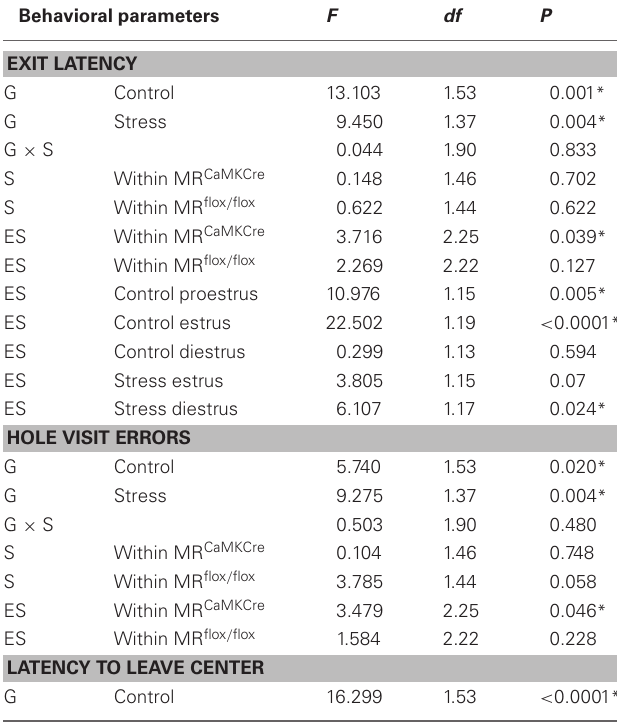
Table 2 | Repeated measurement (ANOVA) results for behavioral performance parameters during the training on the circular hole board tested for genotype (G), stress (S), and estrous cycle in within controls (ES)